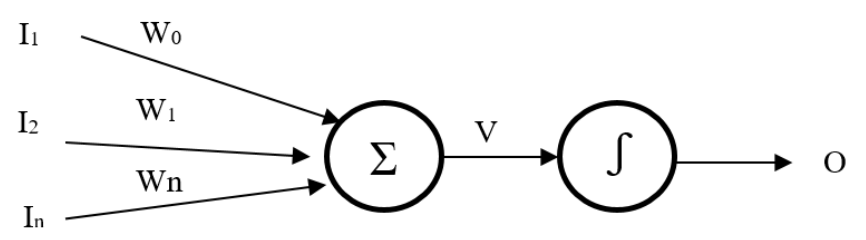
Figure 2. Single-layer perceptron.